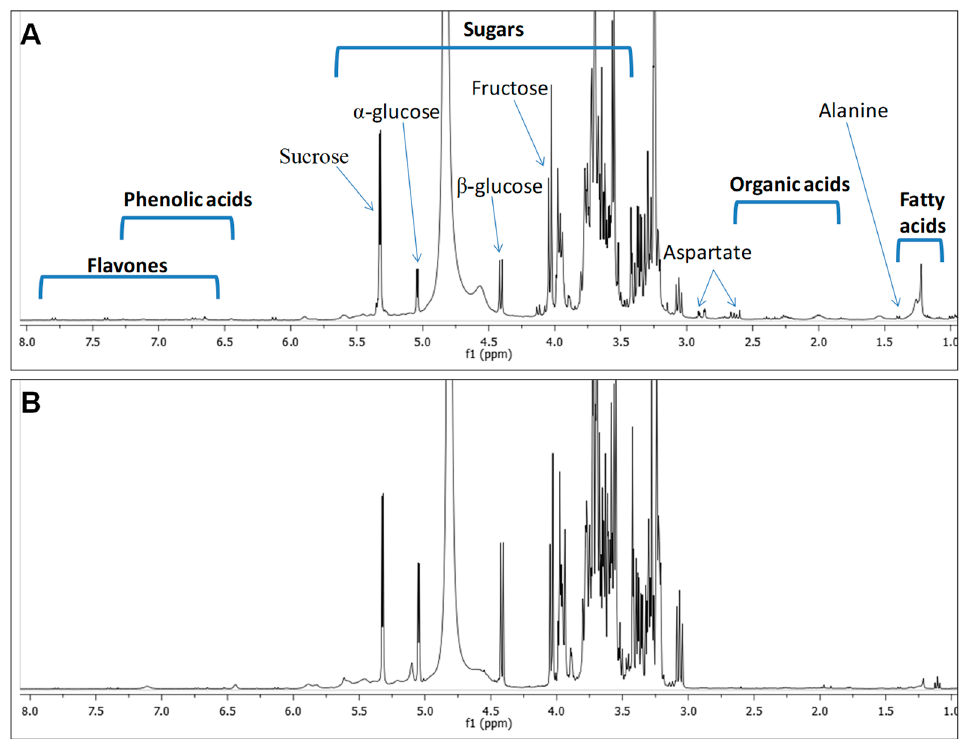
Figure 2. 1 H-NMR spectrum of sugarcane juice ( A ) and molasses ( B ). Identification of peaks is described in Table 1.